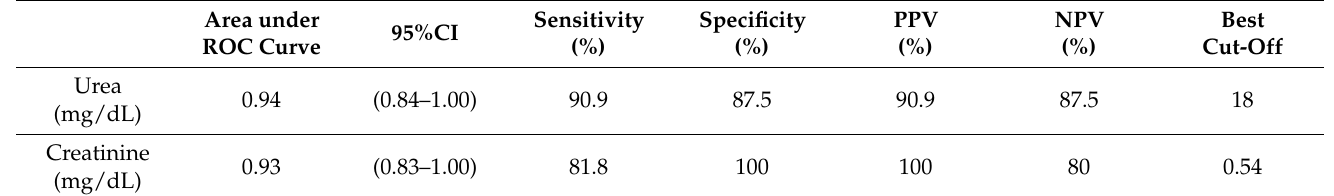
Table 8. Area under curve ROC for the prediction of PE according to laboratory parameters in the first trimester in pregnant women with chronic